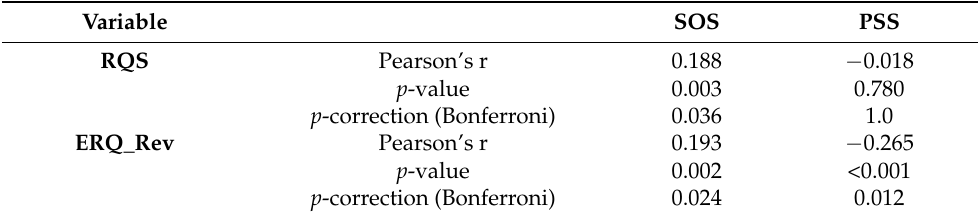
Table 1. The correlation analysis between the perceived stress (PSS), social odours (SOS), romantic relationship quality (RQS), and emotional regulation capacity through revaluation